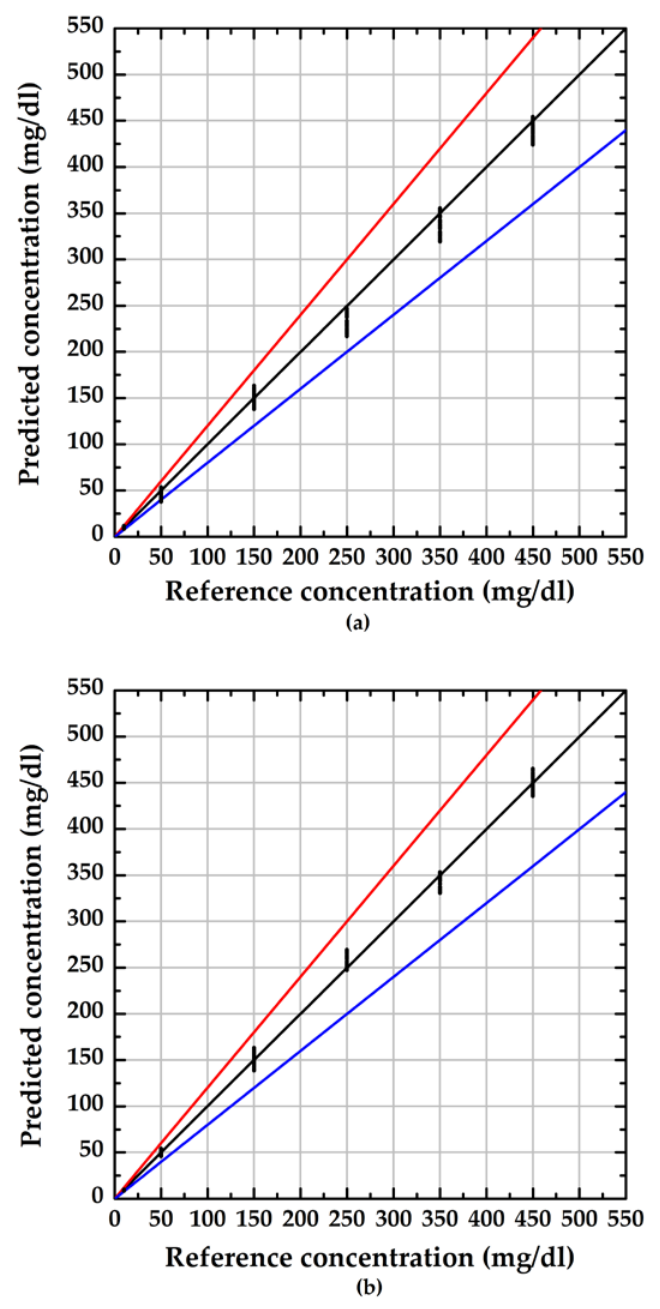
Figure 7. Reliability evaluation of the sensor with various length of the sensor: ( a ) 1 cm; ( b ) 3 cm. Figure 8 indicates that the calibration curve measured of the proposed method with various lengths of sensor. The symbols , (cid:3) , and I represent the average value of 10 measured data sets and the standard deviation of each concentration measured by the proposed sensor with 1 cm and 3 cm long sensors, respectively. The slope of the calibration curve indicates the sensitivity of the proposed method; the phase variation was approximately − 0.026 ◦ for 1 mg/dL for the measurement by the sensor length of 1 cm and − 0.052 ◦ for 1 mg/dL for the measurement by the sensor length of 3 cm. The shaper slope indicates a higher sensitivity, and obviously the sensor length of 3 cm provided higher sensitivity for glucose concentration measurement. The results show that the linear measurement range of the proposed method covers glucose concentrations from 10 to 550